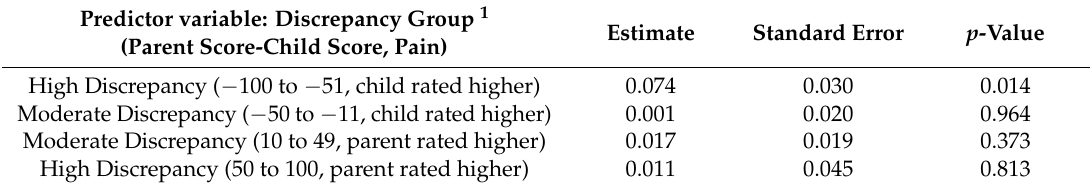
Table 3. Relationship between simple difference of pain score and mean negative mood score. Predictor variable: Discrepancy Group 1